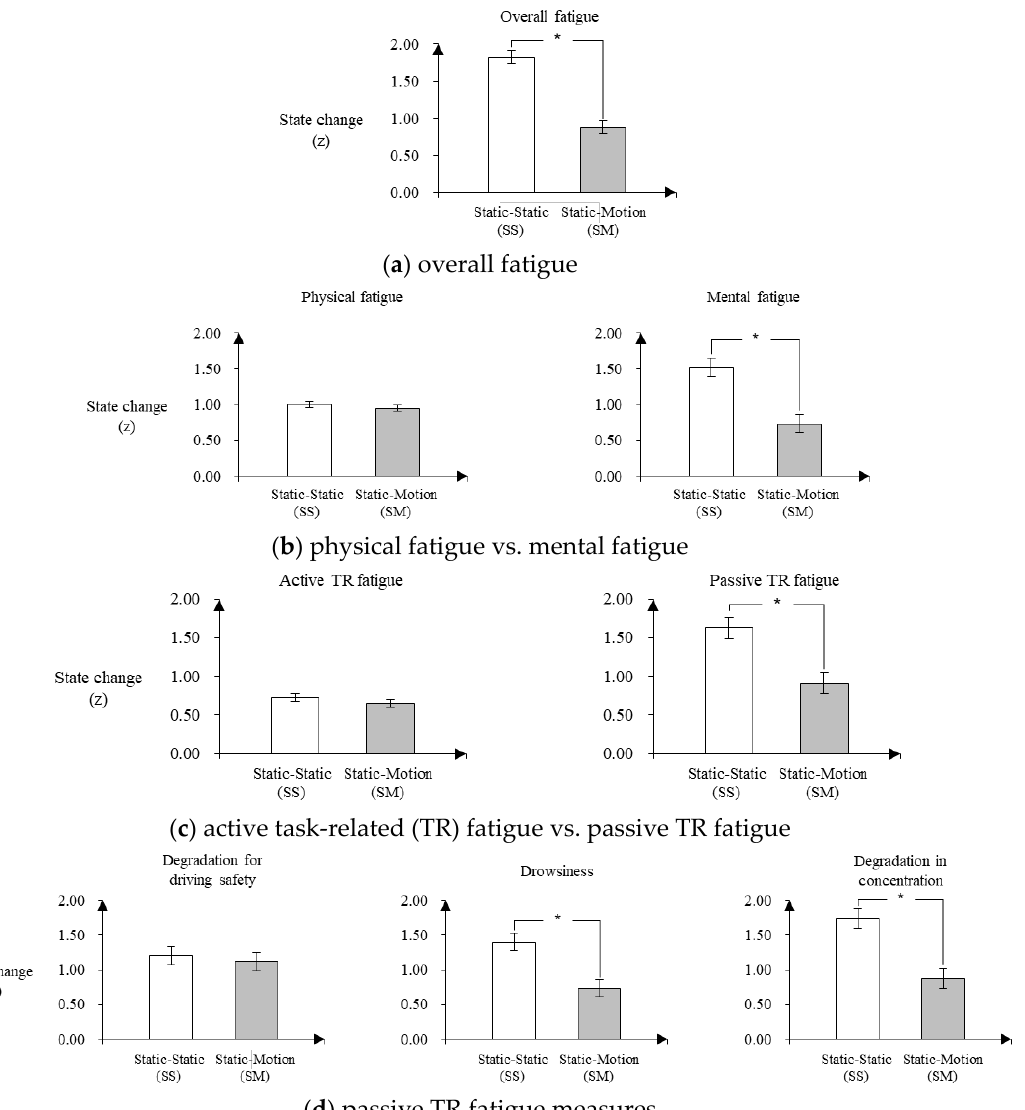
Figure 7. Fatigue state changes between the before- and after-driving sessions for the static- and motion-seat conditions.